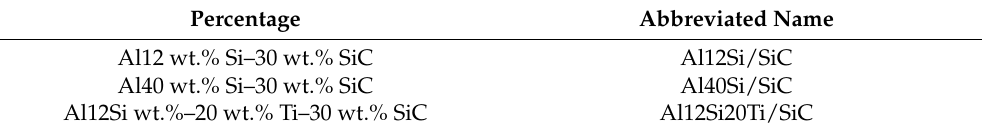
Table 2. Cladding powder proportions.